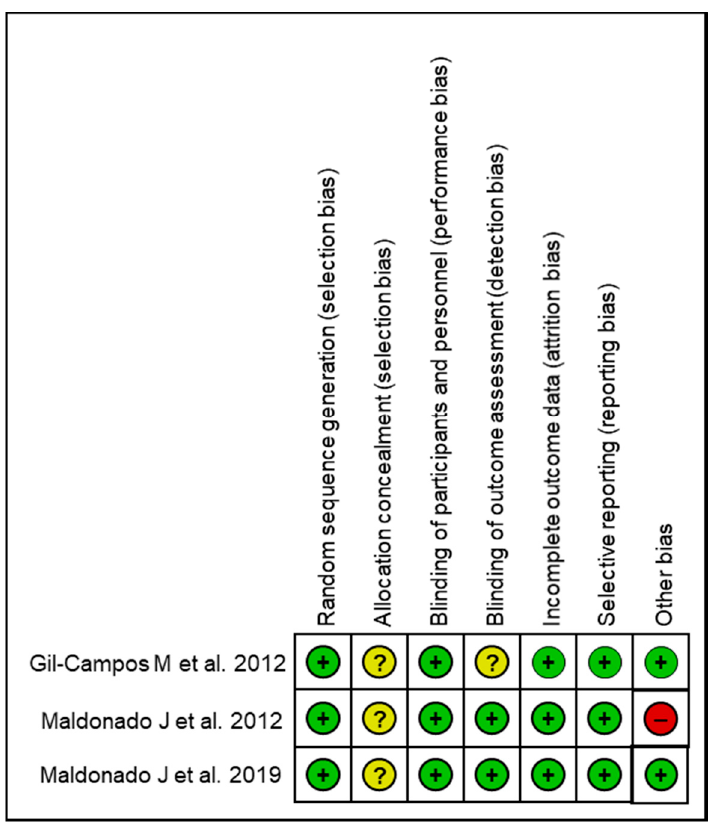
Figure 3. Summary of risk of bias assessment of included studies. Green (+): Low risk; Red ( − ): High risk; Yellow (?): Unclear risk.